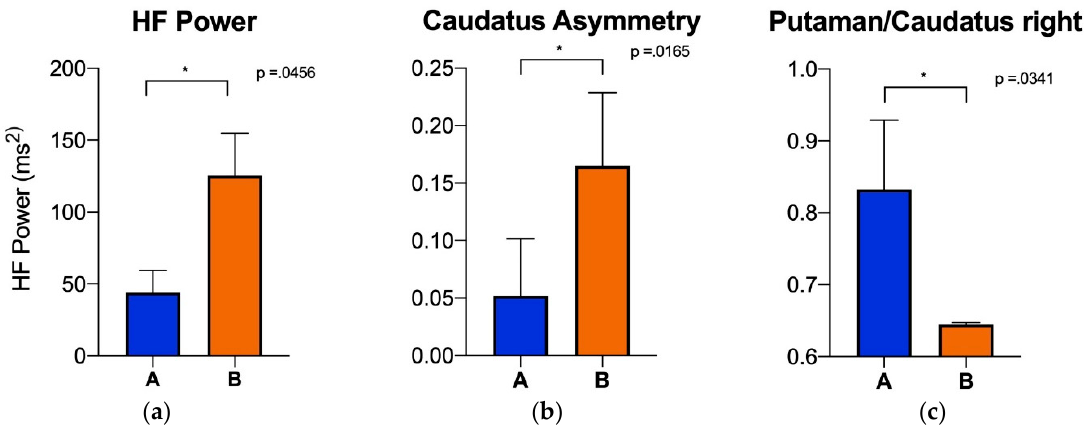
Figure 7. Groups were clustered first using T-SNE. Subsequently, patients taking ACE inhibitors were excluded from the analysis to minimize confounding effects on autonomic function (which included all the patients in Group C, and thus, only Groups A [blue] and B [orange] are shown). The analysis shows significant difference between the two groups for all parameters. ( a ): HF (high frequency; p -value = 0.0456) power; ( b ): caudate asymmetry ( p -value = 0.0165); ( c ): right putamen/caudate ratio ( p -value = 0.0341). Error bars indicate the standard deviation, * indicates p -value < 0.05. The raw data showed most patients’ left caudate SBR to be lower than the right, and only two patients’ right caudate SBR was lower than the